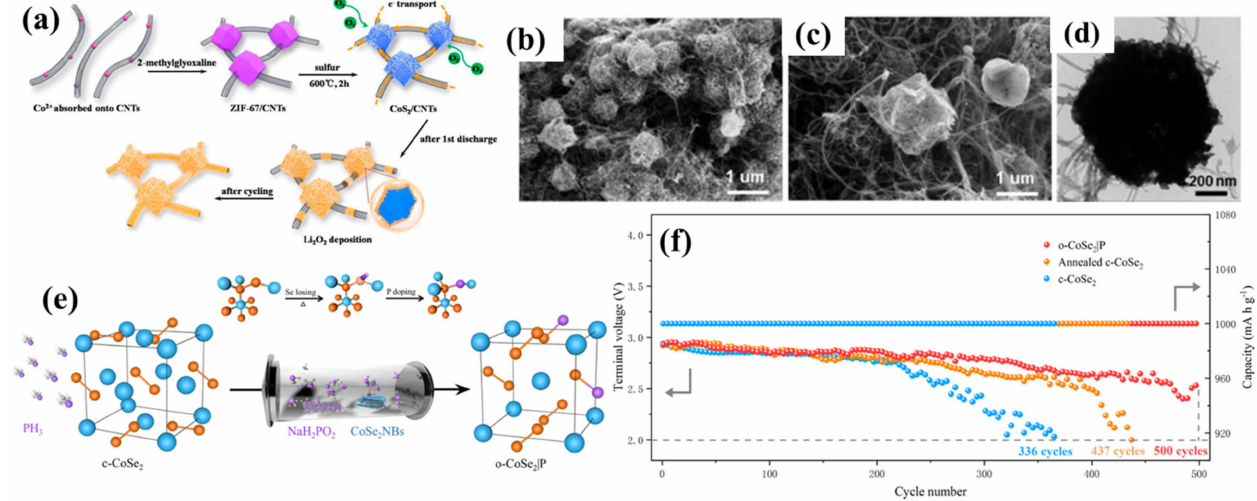
Figure 15. ( a ) Illustration of the CoS 2 /CNTs composite fabrication technique. ( b , c ) SEM pictures of CoS 2 /CNTs ( d ) CoS 2 /CNT TEM images. Adapted with permission [325]. Copyright (2020) American Chemical Society. ( e ) The synthesis of o-CoSe 2 |P. P-doped induction of CoSe 2 in the cubic phase into CoSe 2 in the orthogonal phase flow diagram. Co, P, and Se atoms are represented by blue, purple, and orange spheres, respectively. ( f ) Cycling performance of LiO 2 batteries based on o-CoSe 2 |P, annealed c-CoSe 2 , and c-CoSe 2 with a limited capacity of 1000 mAh/g at a current density of 50 mA/g at a current density of 50 mA/g at a current density of 50 mA/g. Adapted with permission [326]. Copyright (2020) American Chemical